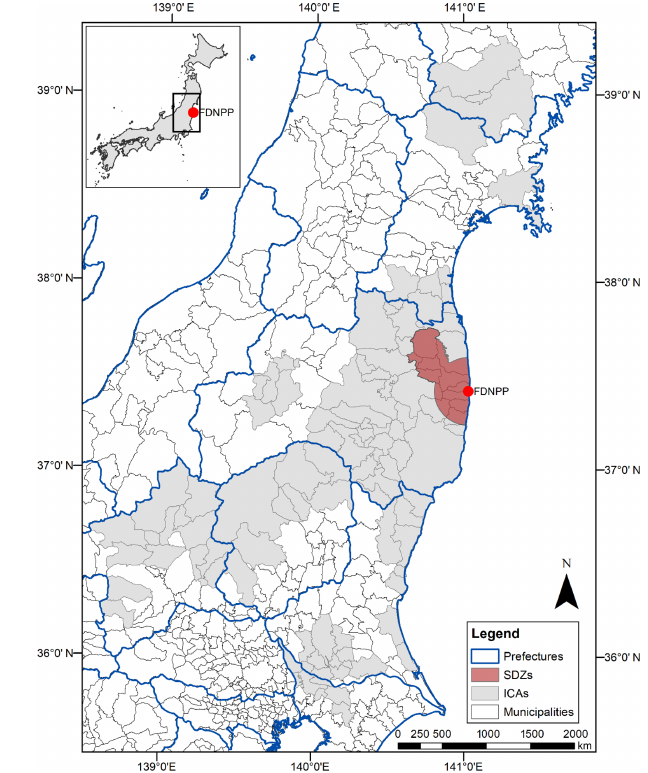
Figure 2. Location of the Fukushima Prefecture in Japan (inset map) and the location of the Special Decontamination Zone (SDZ) and the Intensive Contamination Survey Areas (ICAs). A KMZ file with the locations of the ICAs in Japan is provided as a Supplement to this